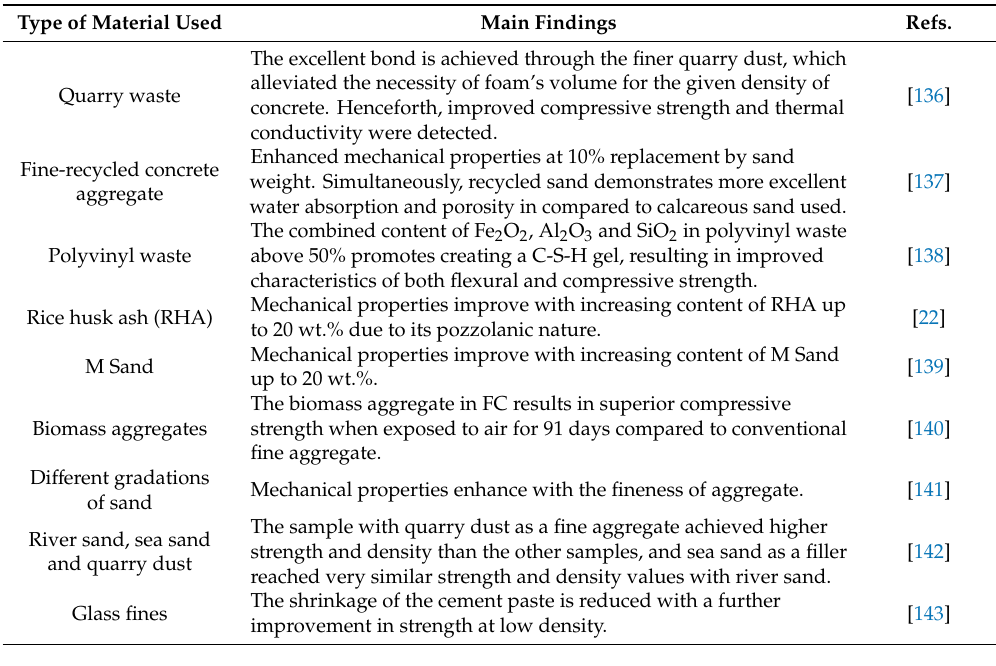
Table 7. E ff ect of the grading of